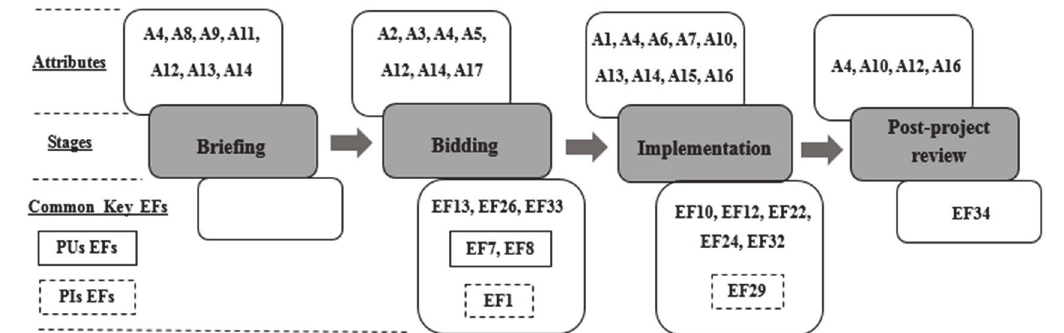
Figure 2. Distribution of key factors along the construction